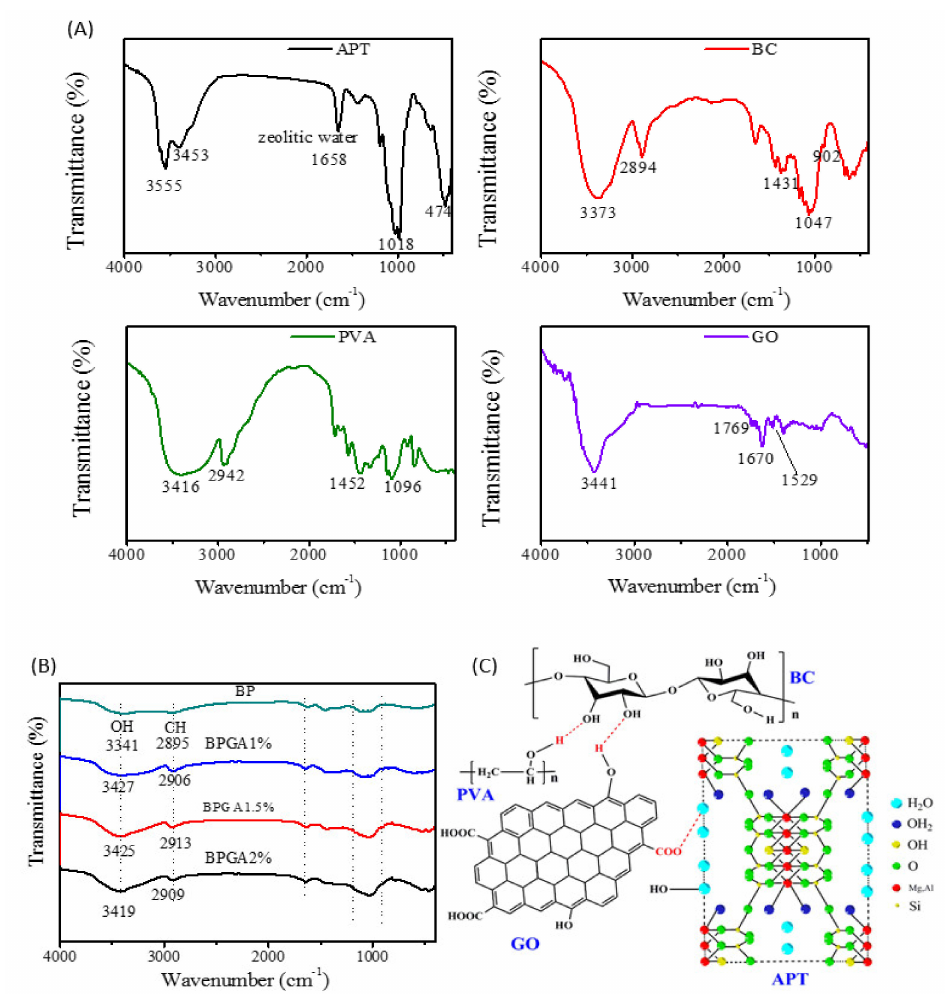
Figure 1. The FTIR spectra of initial components and prepared adsorbent materials. ( A ) represents the FTIR spectra of initial components (APT, BC, PVA, and GO) and ( B ) represents the prepared adsorbent materials (BP, BPGA1%, BPGA1.5% and BPGA2%), ( C ) represents a schematic diagram of the hydrogen bonding of the initial